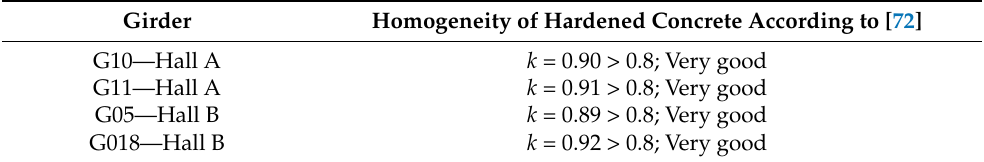
Table 3. The homogeneity of hardened concrete from sclerometer test (girders G10 & G11—Hall A, girders G05 & G018—Hall B).